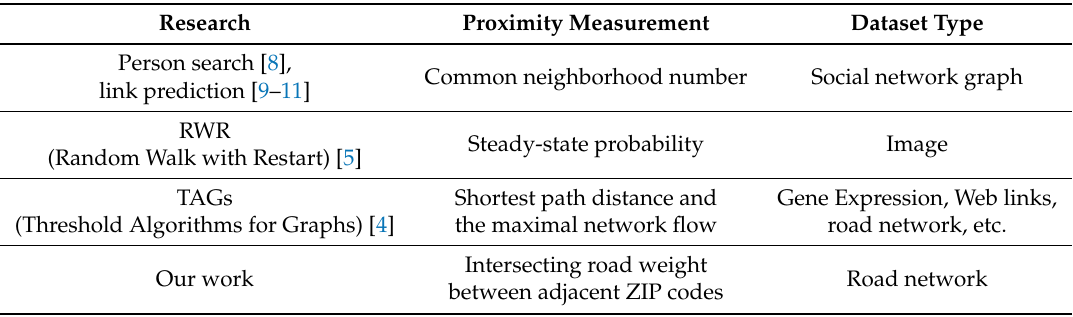
Table 1. Research on proximity computation in a